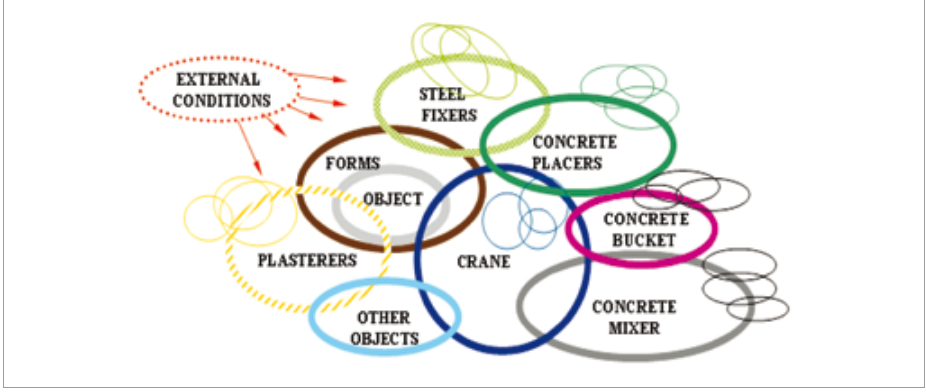
Fig. 2. A conceptual model of complexity of cyclical monolithic construction process